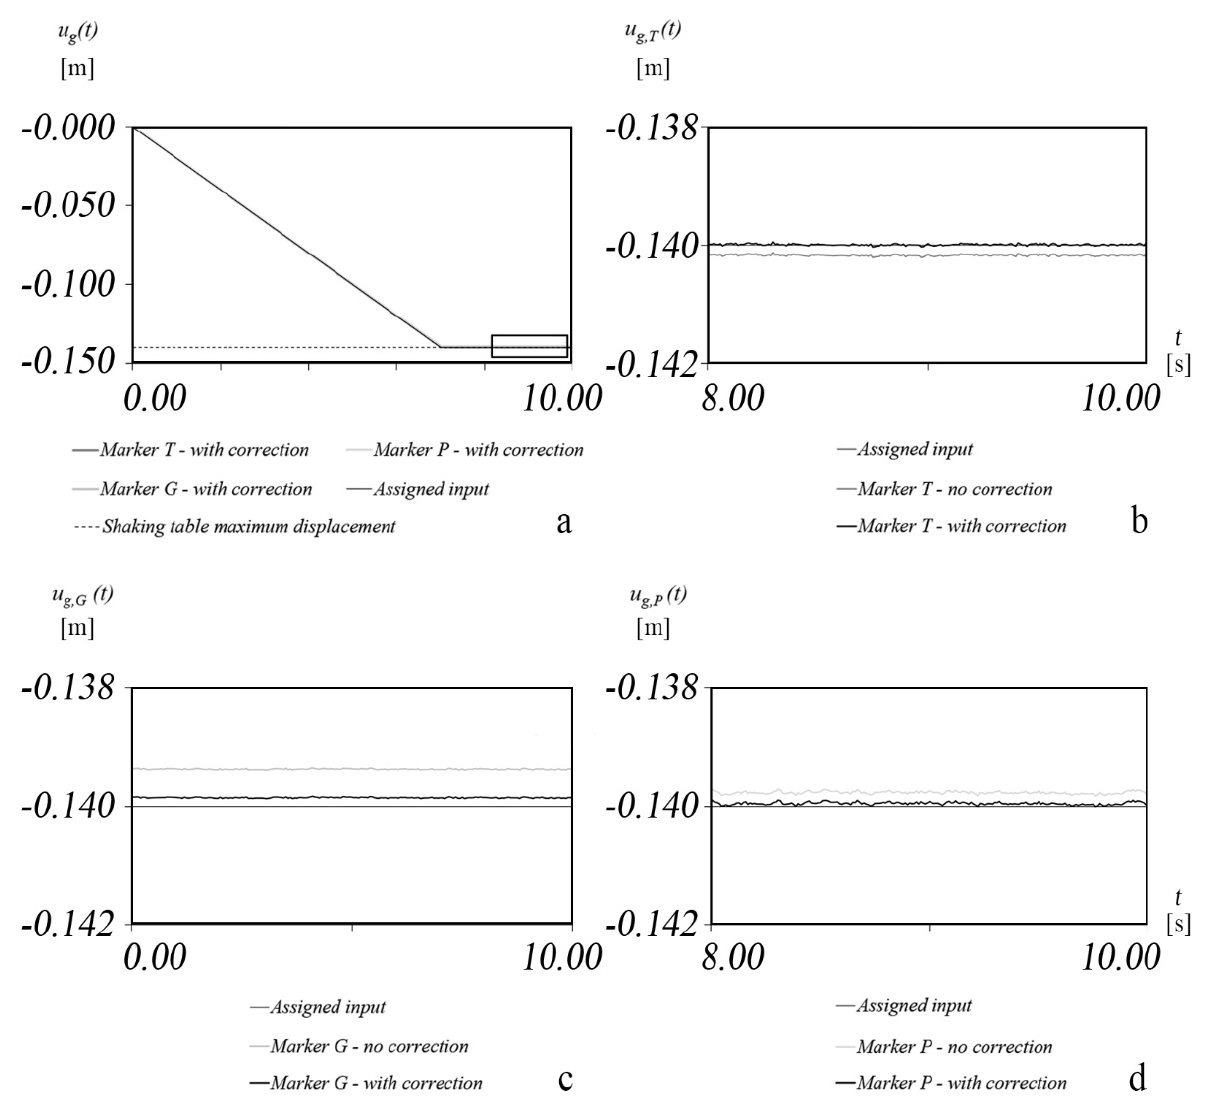
Figure 9. Application of calibration curves: ( a ) comparison camera measurements with shaking table input; ( b ) correction at maximum displacements of points T, ( c ) G, ( d ) and P.